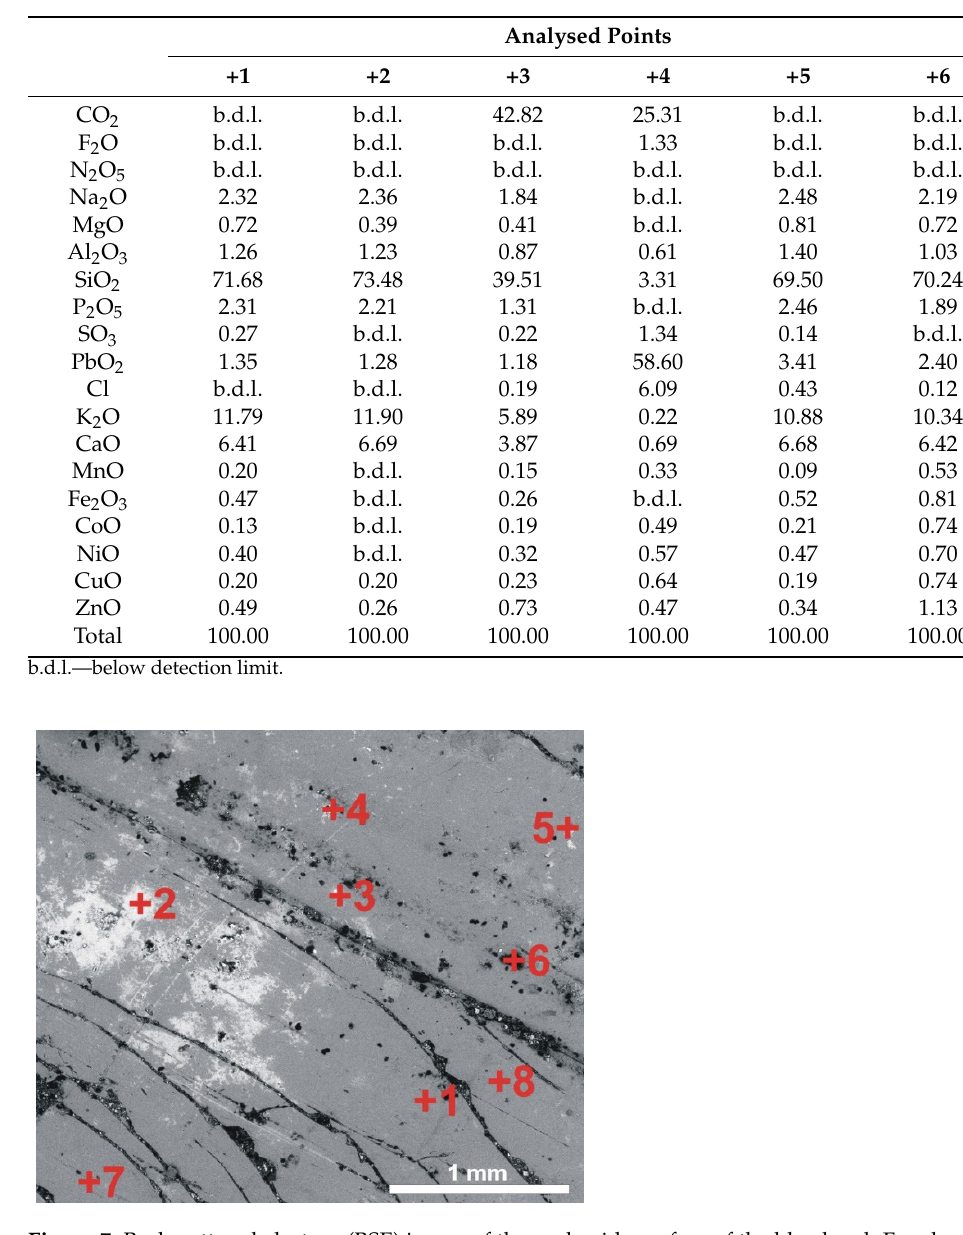
Table 2. Chemical composition, in weight percentage, of the side of the blue bead with ornamentation. For all elements (except anion Cl), the composition is expressed as oxides weight %. The exact positions of the analysed points are shown in Figure 6.